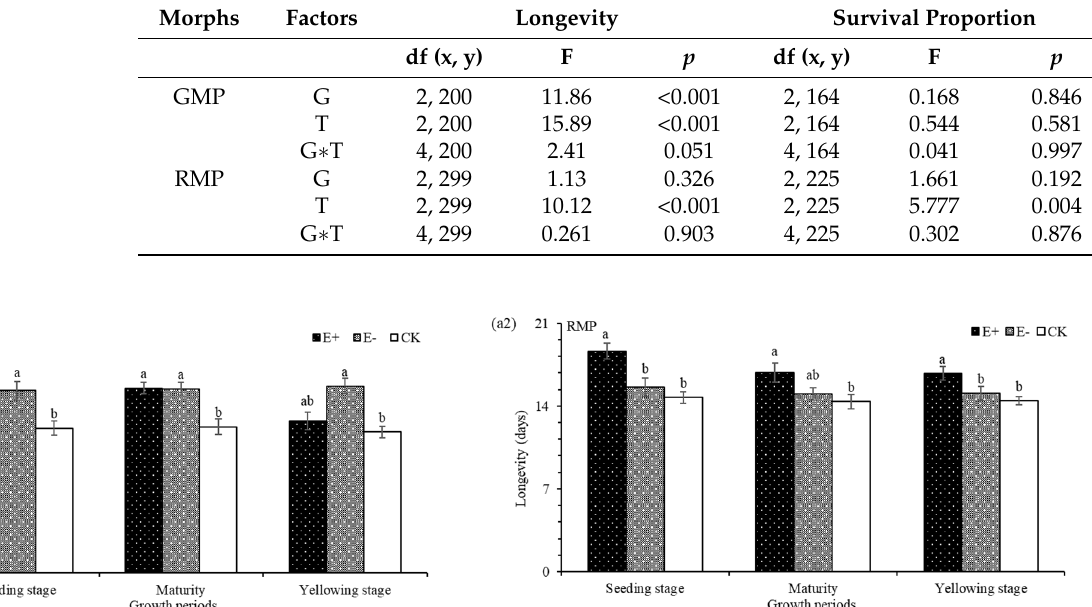
Figure 4. Longevity in green color morphs of pea aphids (GMP) and red color morphs of pea aphids (RMP) treated with aqueous extracts of plants in different growth periods/stages ( a1 and a2 ). E+, endophyte-infected A. inebrians ; E − , endophyte-free A. inebrians ; CK, control. Different capital letters indicate that there are significant differences between different growth periods, and different small letters indicate that there are significant differences between different treatments ( p < 0.05).